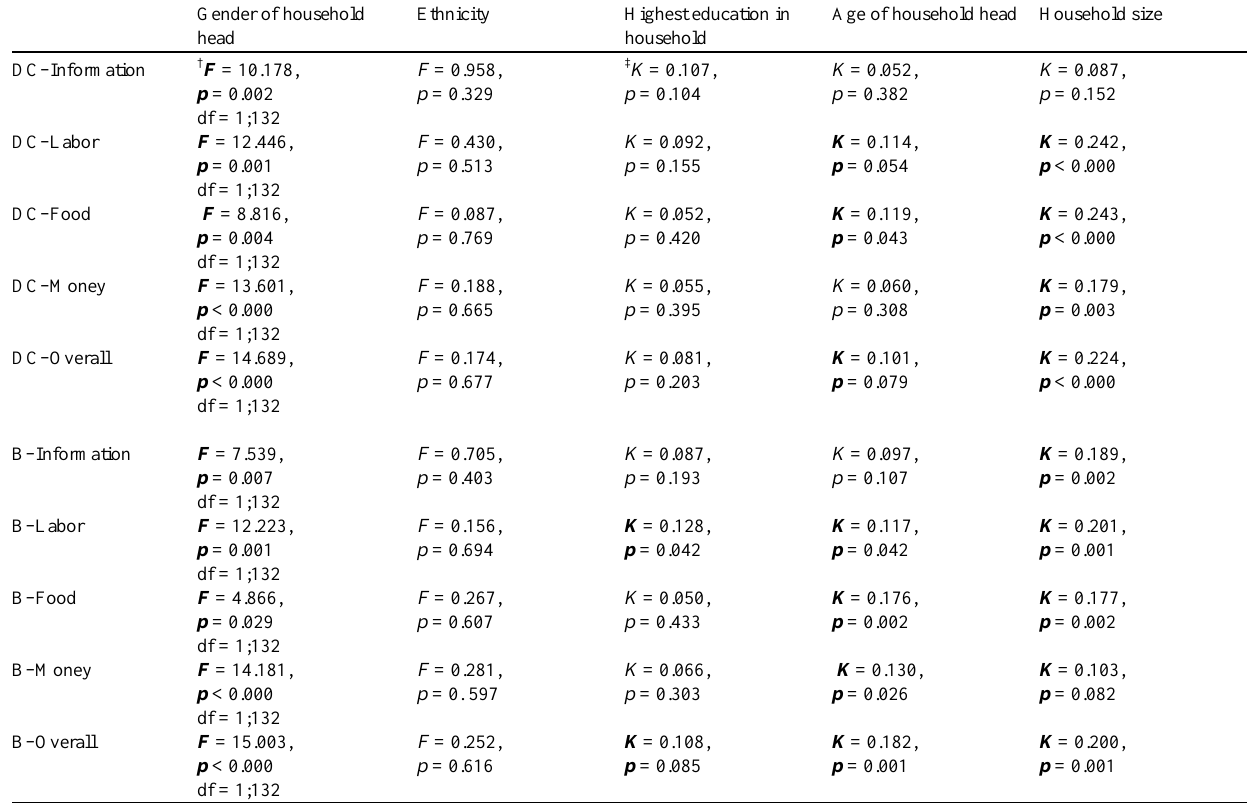
Table 2 . Measures of association between key sociocultural characteristics and the social network metrics of degree centrality (DC) and betweenness (B) for different exchange